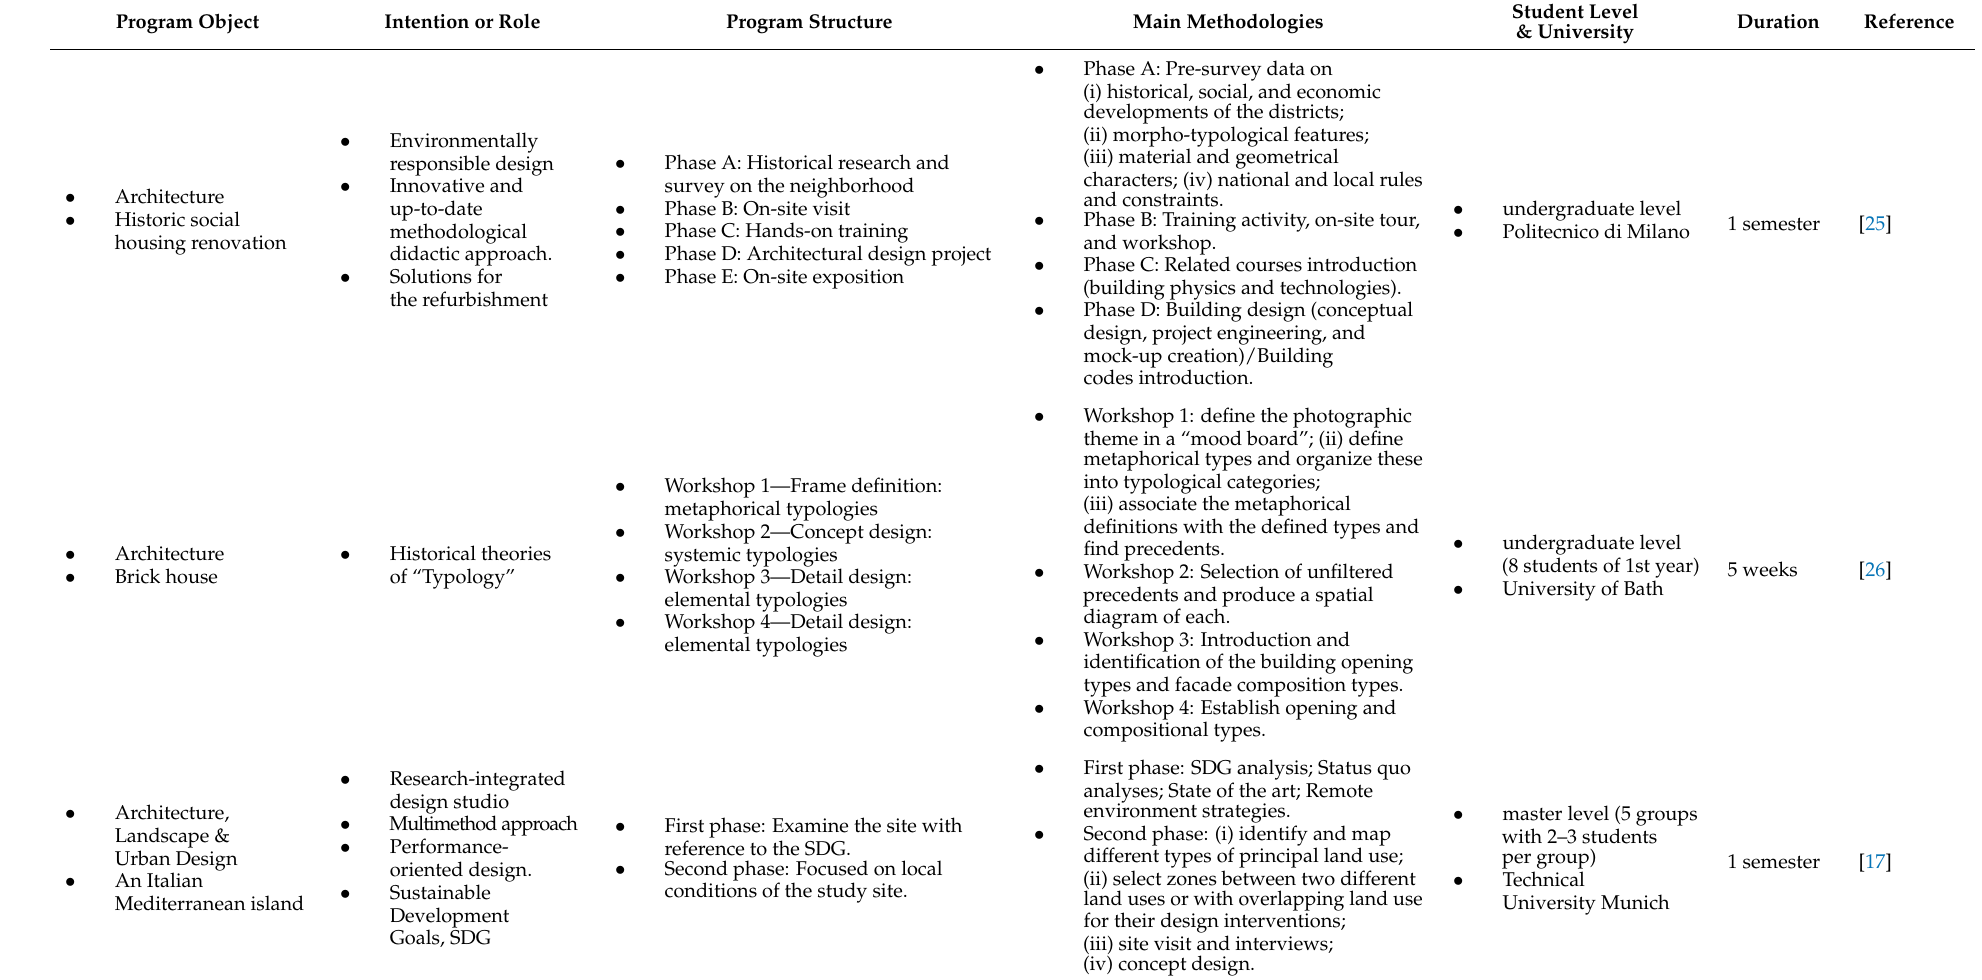
Table 2. Design studios and programs with different intentions, structures, and